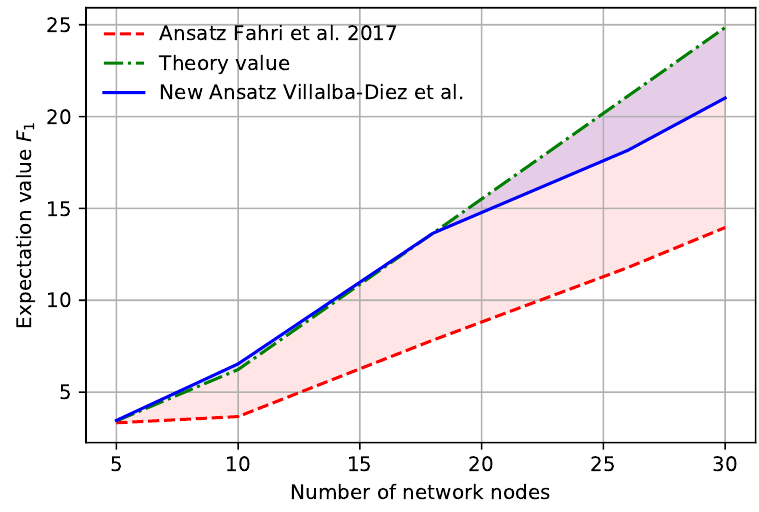
Figure 6. QAOA results comparison. Table 1. Results comparison for different measures for identifying curve similarity [25].